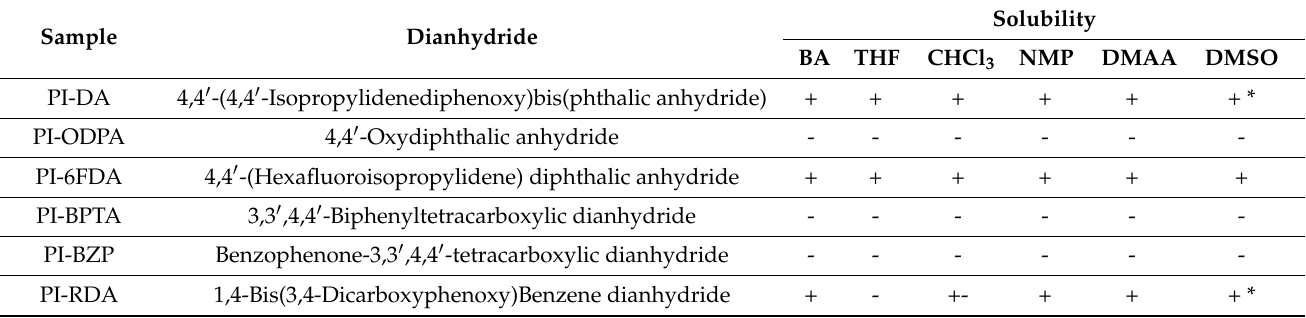
Table 1. Abbreviation of synthesized PIs and their solubility.